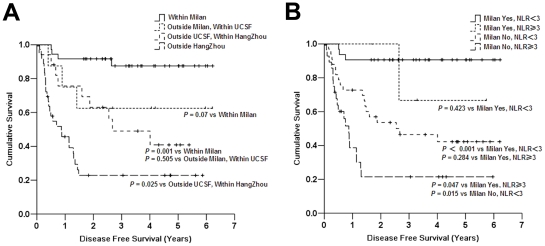
Disease-free survival for patients classified according to NLR and the different criteria.(A) The Kaplan-Meier curves for patients classified according to the Milan, UCSF and HangZhou criteria showed patients within Milan had significantly better DFS than patients outside UCSF but within HangZhou criteria (log rank test, P = 0.001). (B) Among patients beyond Milan criteria, a significant difference in DFS existed between patients with normal and elevated NLR (log rank test, P = 0.015).